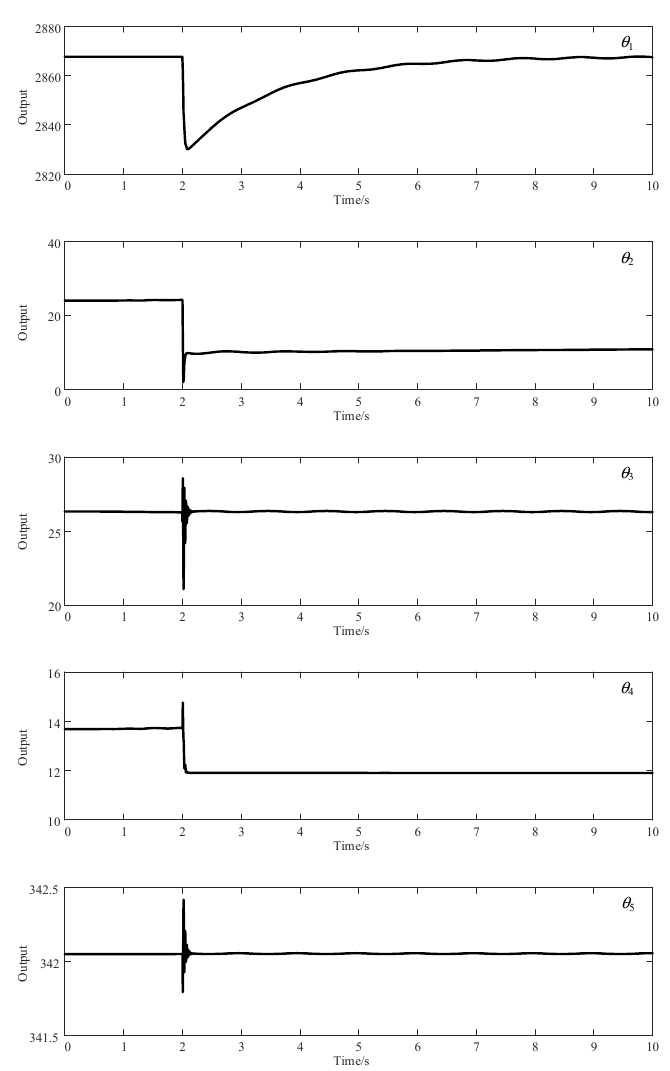
Figure 15. Parameter Variation of ADRRAC Strategy.